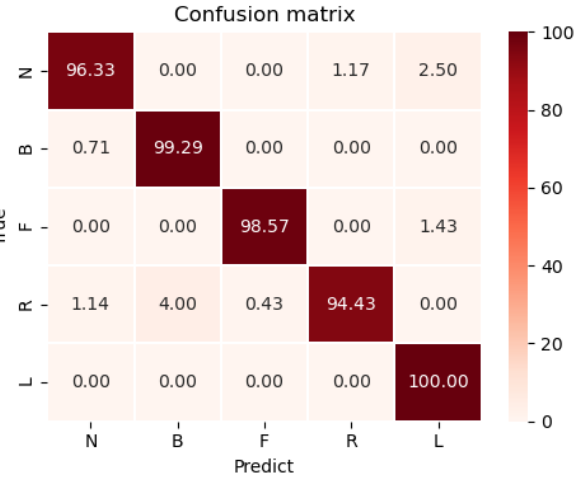
Figure 9. Confusion matrix of the SVM model for five classes with “mixing” dataset: no corrosion (N), backward (B), forward (F), left (L), and right (R).